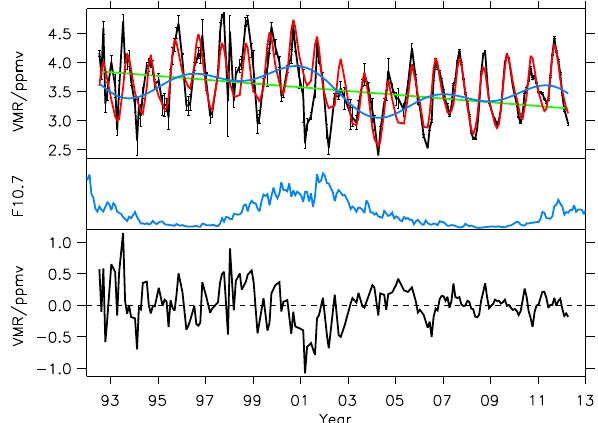
Figure 4. The root mean square improvement of the fit residual with respect to the standard approach, gained by the inclusion of the so- lar cycle approximated by harmonic parametrization as described under Approach 1 in Sect. 4.2. White bins are positive values, i.e. deterioration of the fit.